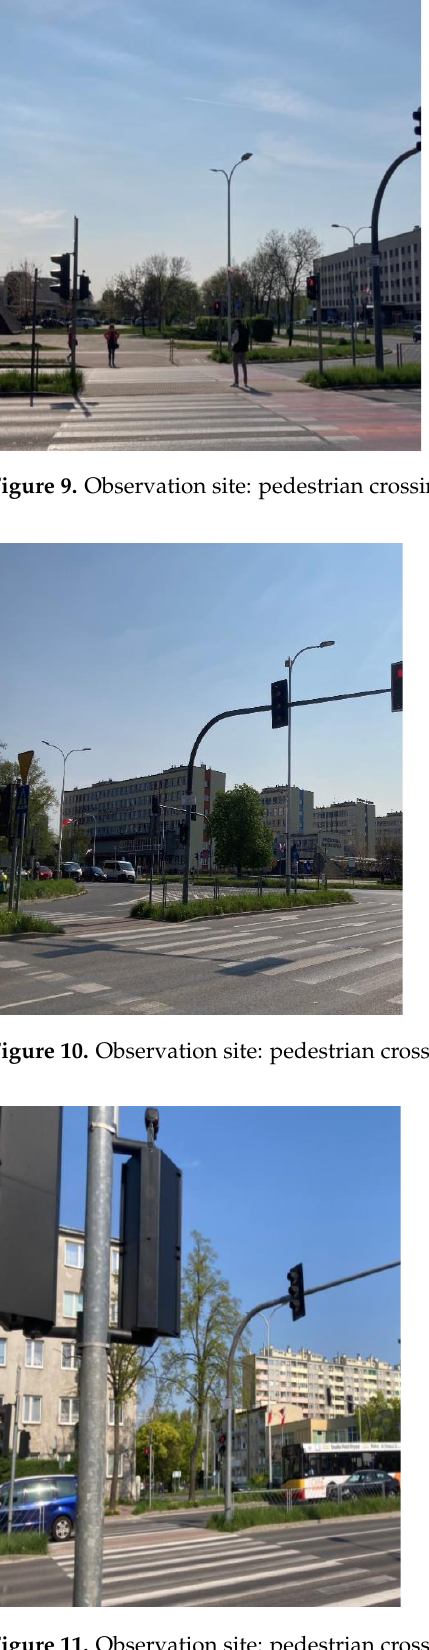
Figure 11. Observation site: pedestrian crossing number 3.